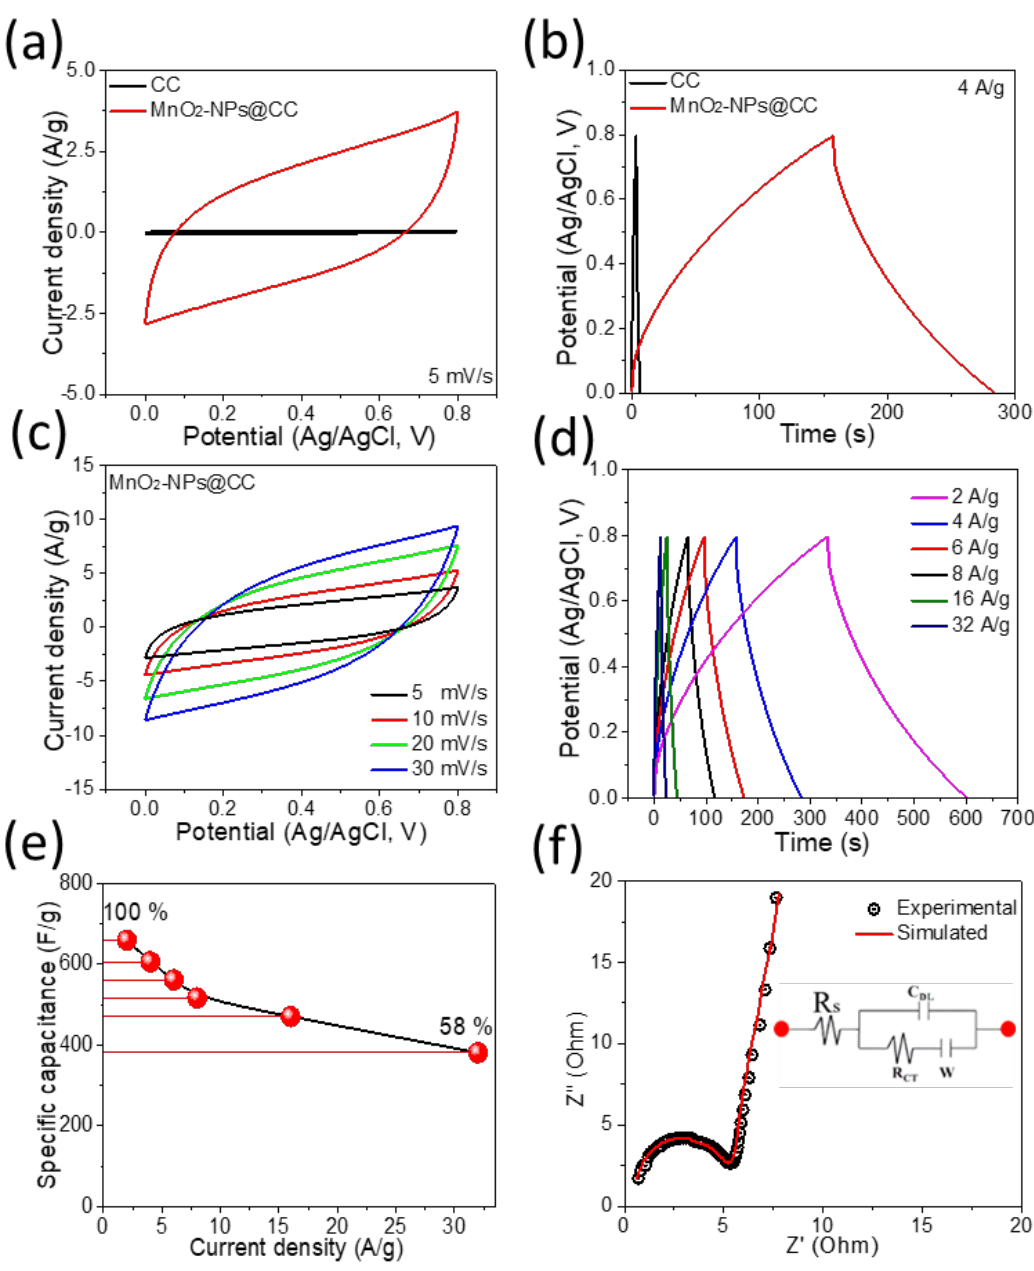
Figure 6. The electrochemical measurements of the MnO 2 -NPs@CC electrode: ( a , b ) comparative CV and GCD curves of MnO 2 -NPs@CC and pristine CC; ( c , d ) CV and GCD curves of MnO 2 -NPs@CC; ( e ) capacitance as a function of the current density; ( f ) Nyquist plot with an electrical equivalent circuit.